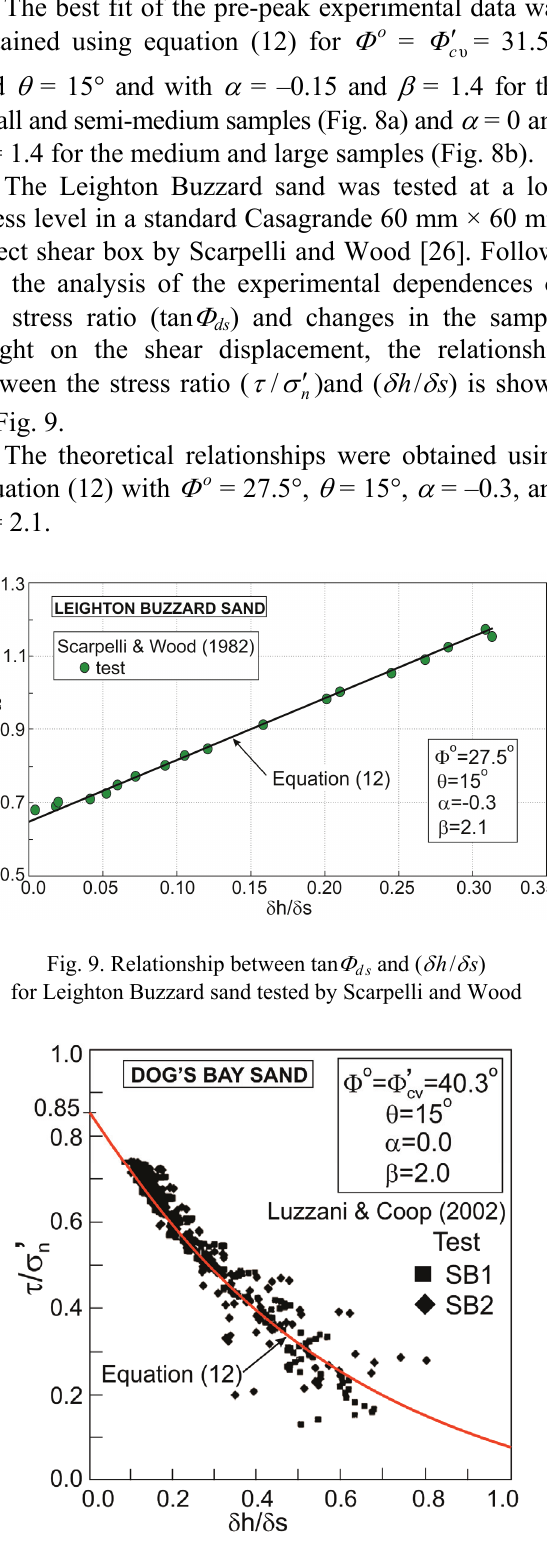
Fig. 10. Stress-dilatancy relationship for shear box tests on Dog’s Bay